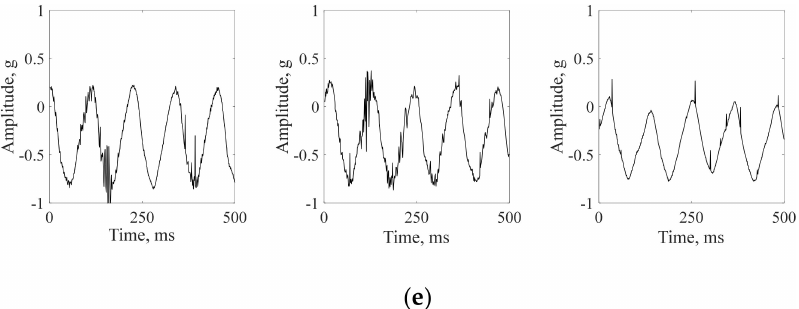
Figure 3. Time domain distribution with blockage degree of I 0%, II 50% and III 100% under the throughput ( a ) 8, ( b ) 10, ( c ) 12, ( d ) 14 and ( e ) 16 m 3 / h.